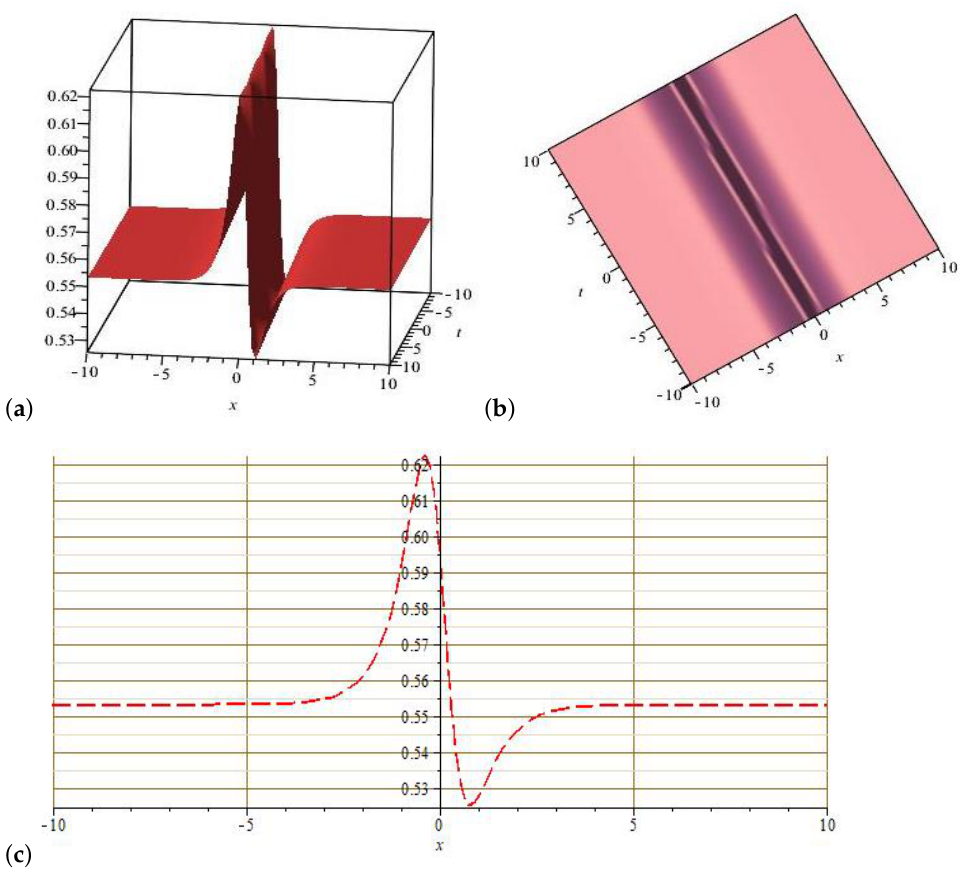
Figure 5. Graphical view of | Q 18 ( (cid:36) ) | for a 1 = 0.07, v = 0.9, w = − 0.7, u = 0.6, a 0 = 0.6, (cid:101) = 0.03: